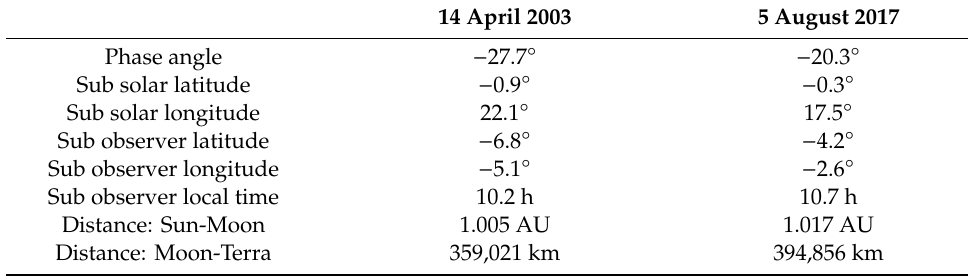
Table 2. Observation geometries in the ASTER lunar observations on 14 April 2003 and 5 August